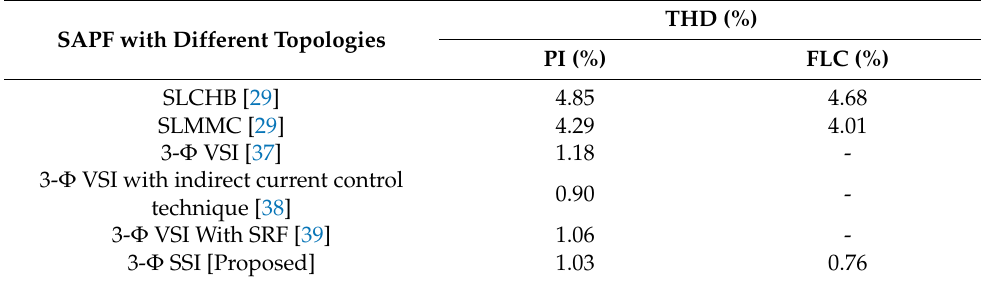
Table 4. THD analysis of the proposed inverter with other topologies with only RL load. SAPF with Different